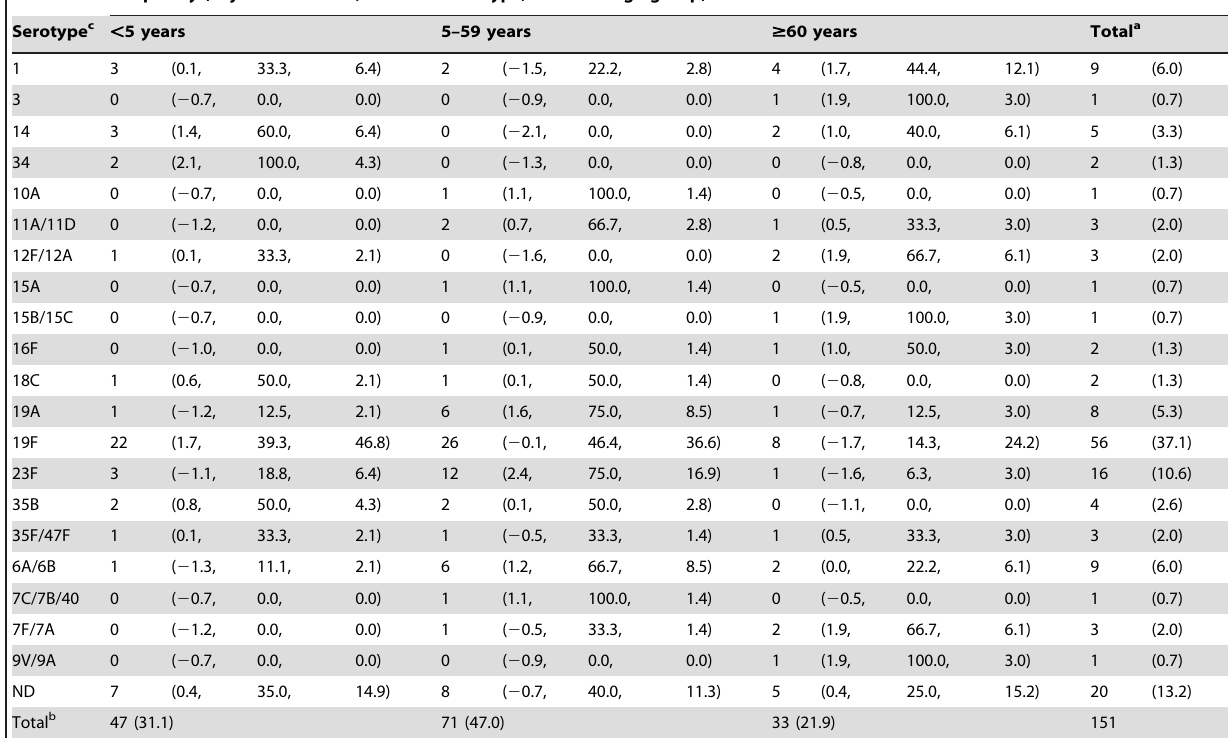
Frequency (adjusted residual, % within serotype, % within age group) Serotype c , 5